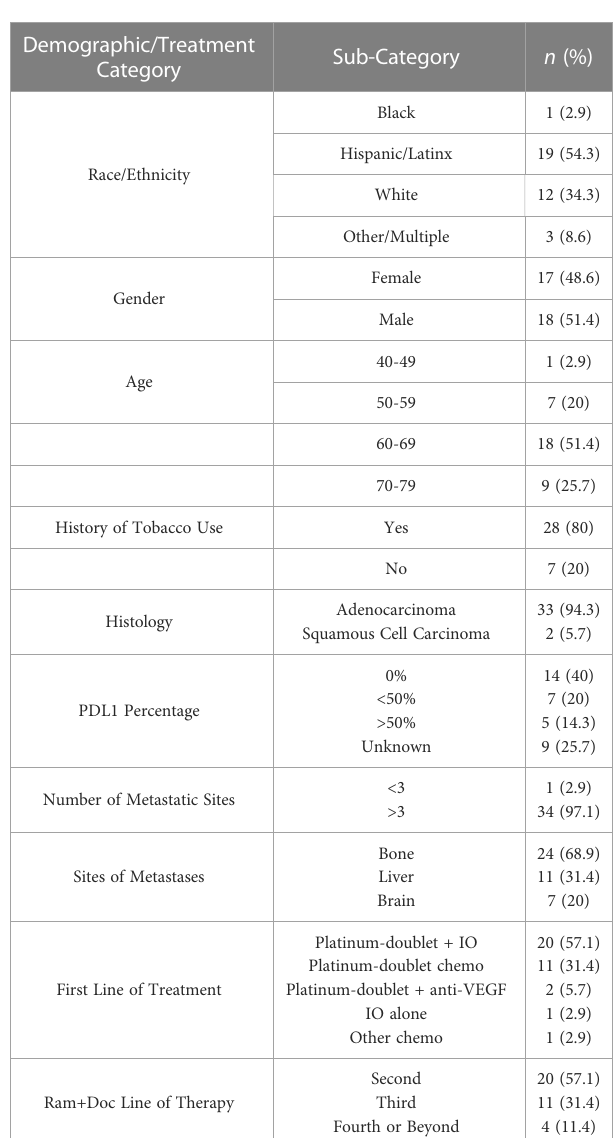
TABLE 1 Demographics of patients whom received ramucirumab and docetaxel, and characteristics of treatment, at the University of